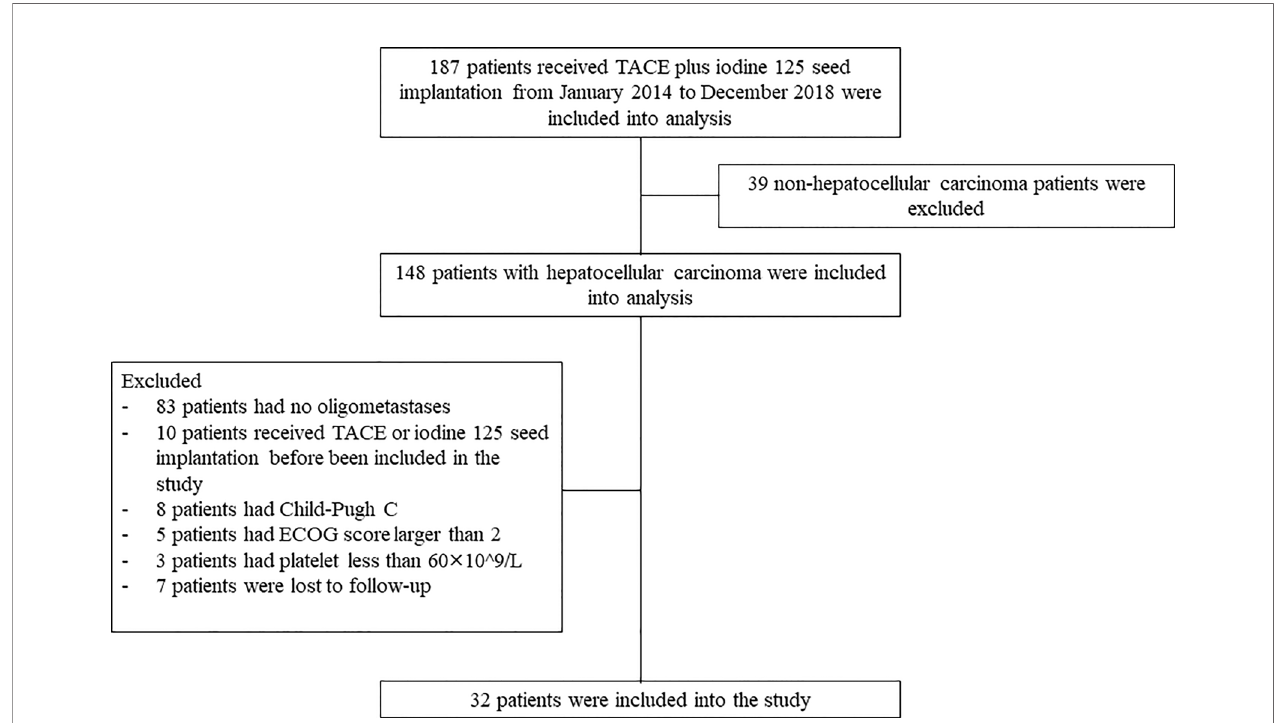
FIGURE 1 | The fl owchart of patient selection.